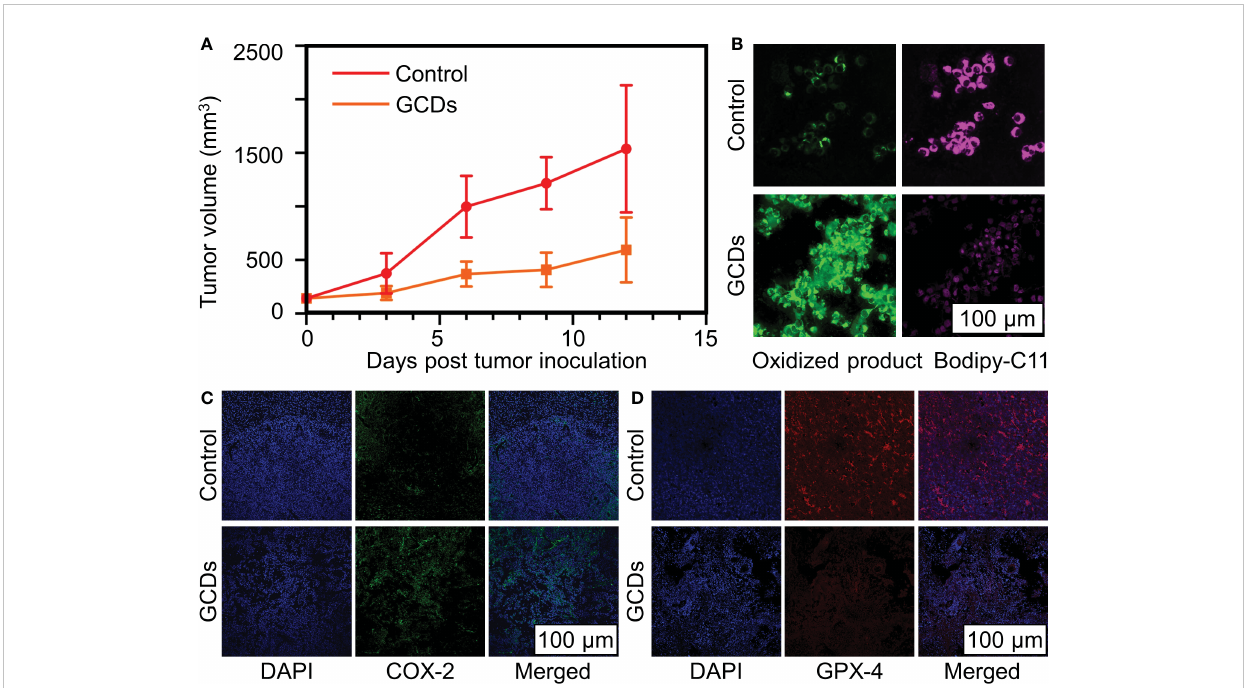
FIGURE 6 Ginseng-based carbon dots (GCDs) inhibit cancer growth in vivo . (A) Tumor volume (mm 3 ) on mice after being treated with GCDs compared to the control group over 12 days. (B) Reactive oxygen species (ROS) levels in cancer cells by immuno fl uorescence for bodyipy-C11 sensitivity. (C, D) Immuno fl uorescence of tumor for COX-2 and d GPX-4 expression in control and GCDs group. Data are presented as mean ± SD from three